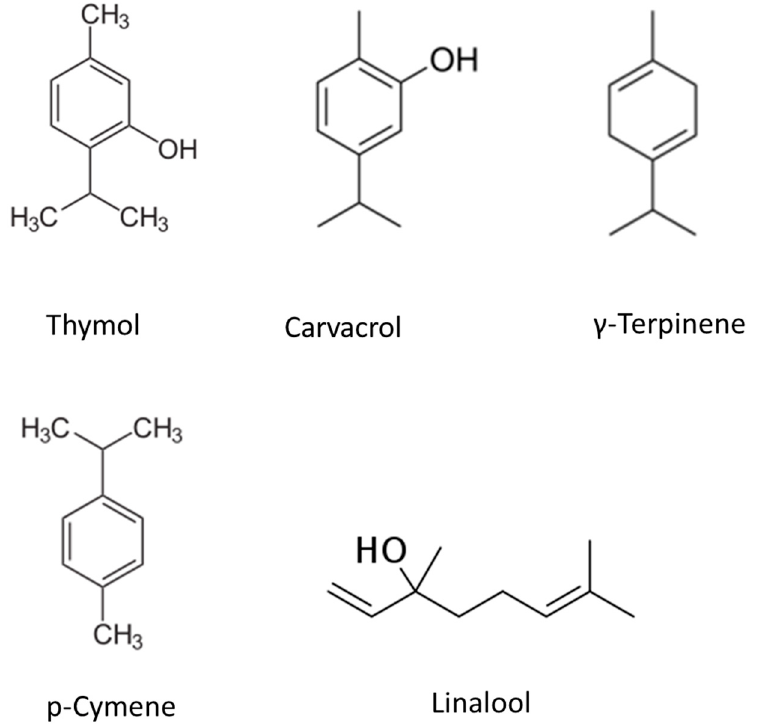
Figure 1. Chemical structures of thymol, carvacrol, p-cymene, γ -terpinene, and linalool.